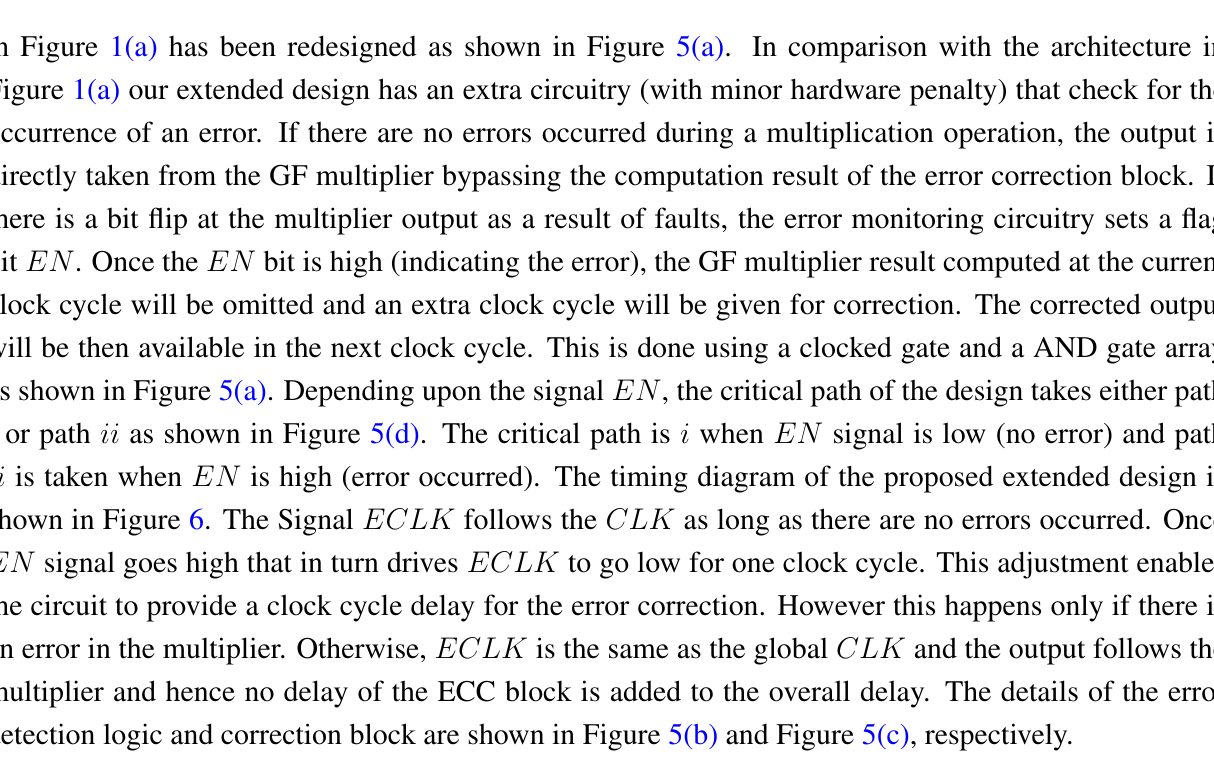
Figure 4. Critical Path of a BCH Code Based Multiple ECC Circuit without Dynamic Error Correction